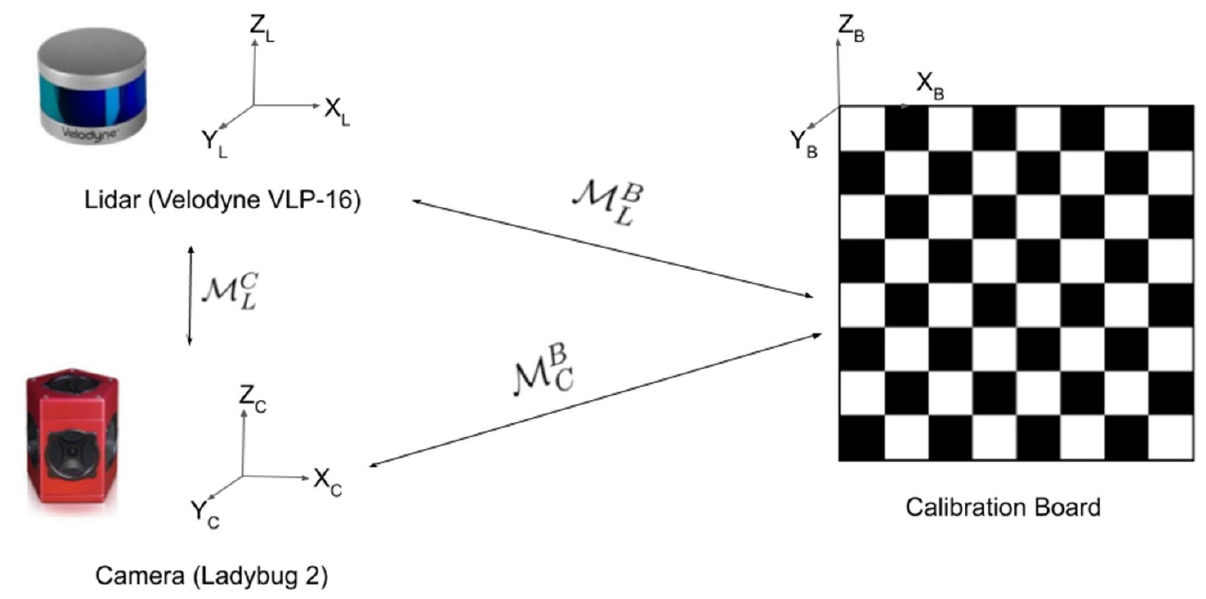
Figure 7. Principle of extrinsic calibration. The objective is to find the rigid transform between the LiDAR and the camera. It is currently mostly done manually using a calibration target, such as a 2D or 3D chessboard or pattern. Reprinted from Ref. [110] with permission of Sensors (Basel) 2020.